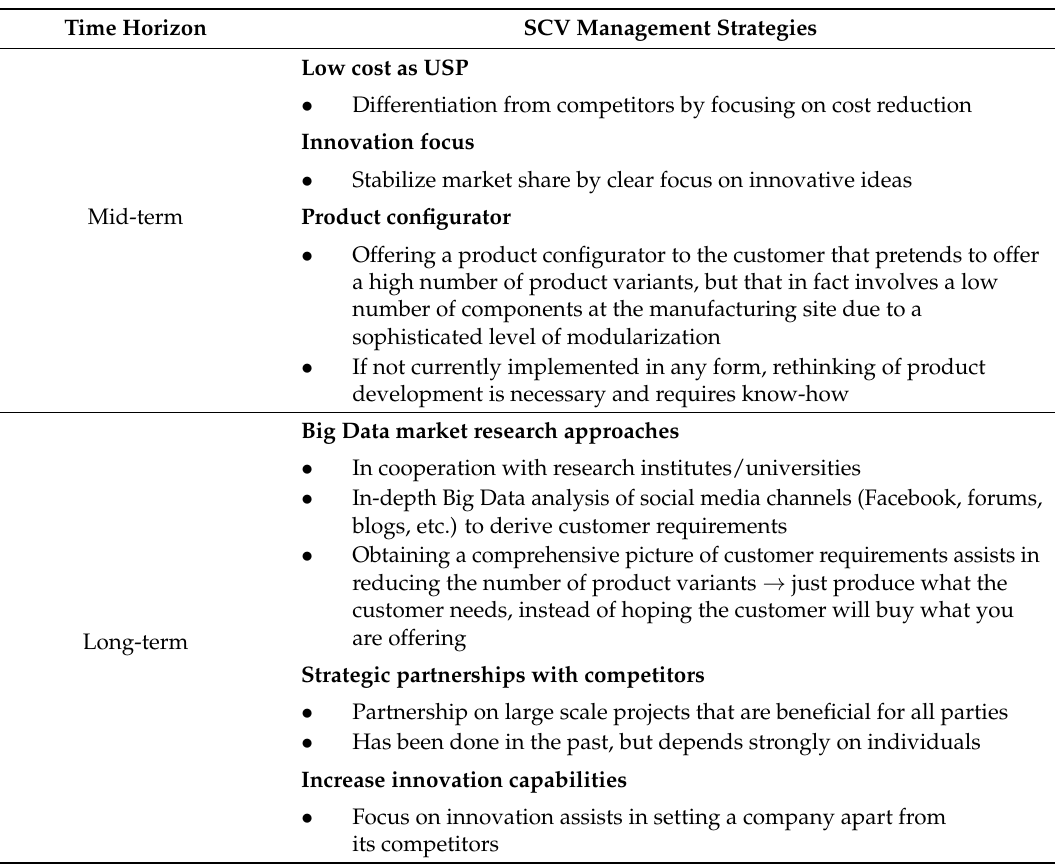
Table 10. SCV management strategies dealing with high level of